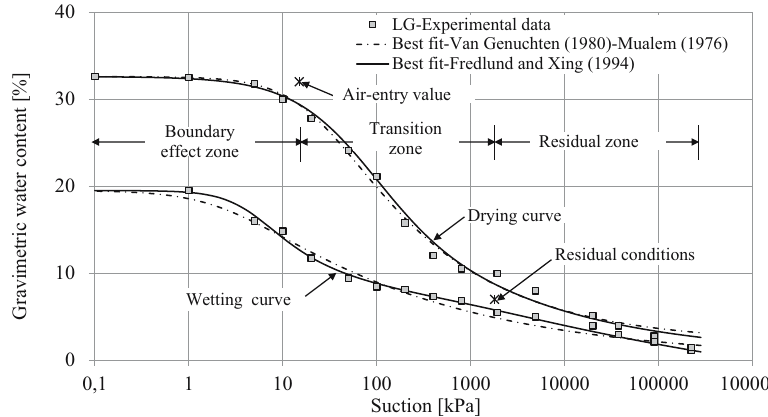
Figure 6: Soil – water characteristic curve, gravimetric water content versus suction for LG soil.